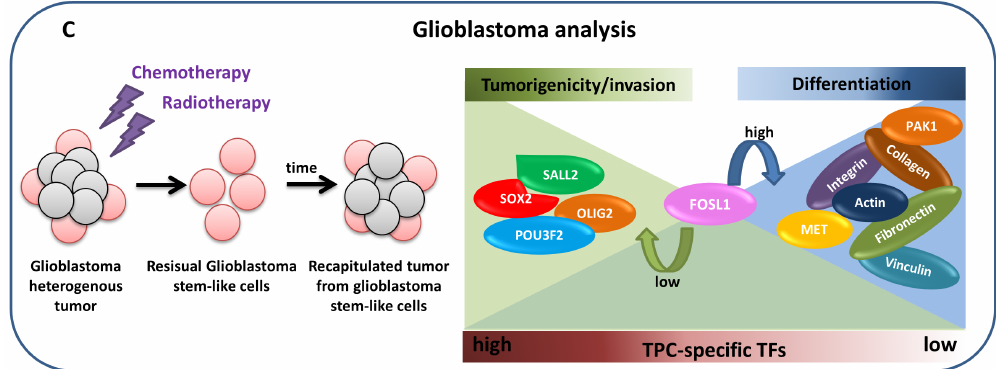
Figure 6. SWIM applications in (A ) grapevine analysis [29], ( B ) multi-cancers analysis [28], and ( C ) glioblastoma analysis [30]. ( A ) A sketch of the switch gene regulation mechanism in grapevine. During the vegetative/green phase of organ development, switch genes are repressed by miRNAs and vegetative genes are expressed. In the transition to the mature/red phase, these miRNAs are deactivated, the switch genes are expressed and their anti-correlated vegetative genes are turned off. The heat map shows the transcription level of positively and negatively correlated genes with a typical switch, where expression values increase from blue to red. ( B ) A sketch of the switch gene regulation mechanism in human cancers. SWIM extracted a set of 100 cancer-recurrent switch genes across four tumors—breast invasive carcinoma (brca), lung squamous cell carcinoma (lusc), lung adenocarcinoma (luad), uterine corpus endometrial carcinoma (ucec)—that showed a marked functional